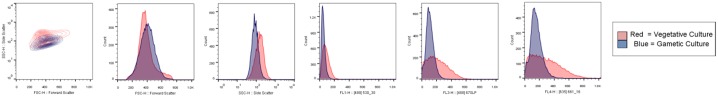
Fluorescence and scatter shifts between two differentiated cell types.Histogram display of overlap in fluorescence intensity of vegetative (immediately after re-suspension in nitrogen free media) and gametic (24hours in nitrogen free media) in late logarithmic cultures. Vegetative distributions are represented in light grey, gametic distributions in dark grey. Note overlap in all scatter and fluorescence channels.